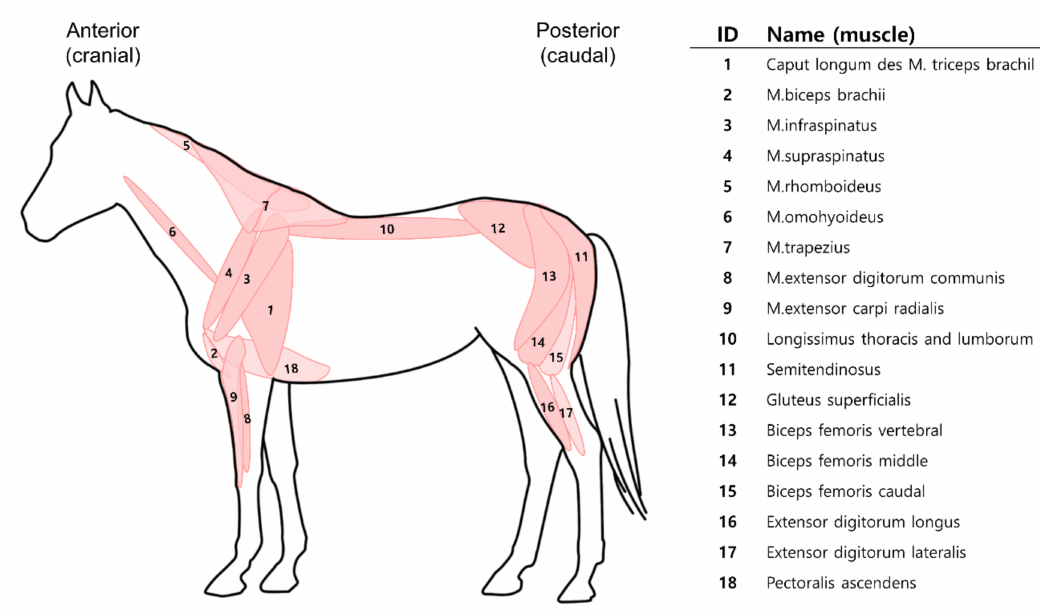
Figure 1. Name and location of 18 skeletal muscle tissues of Equus caballus